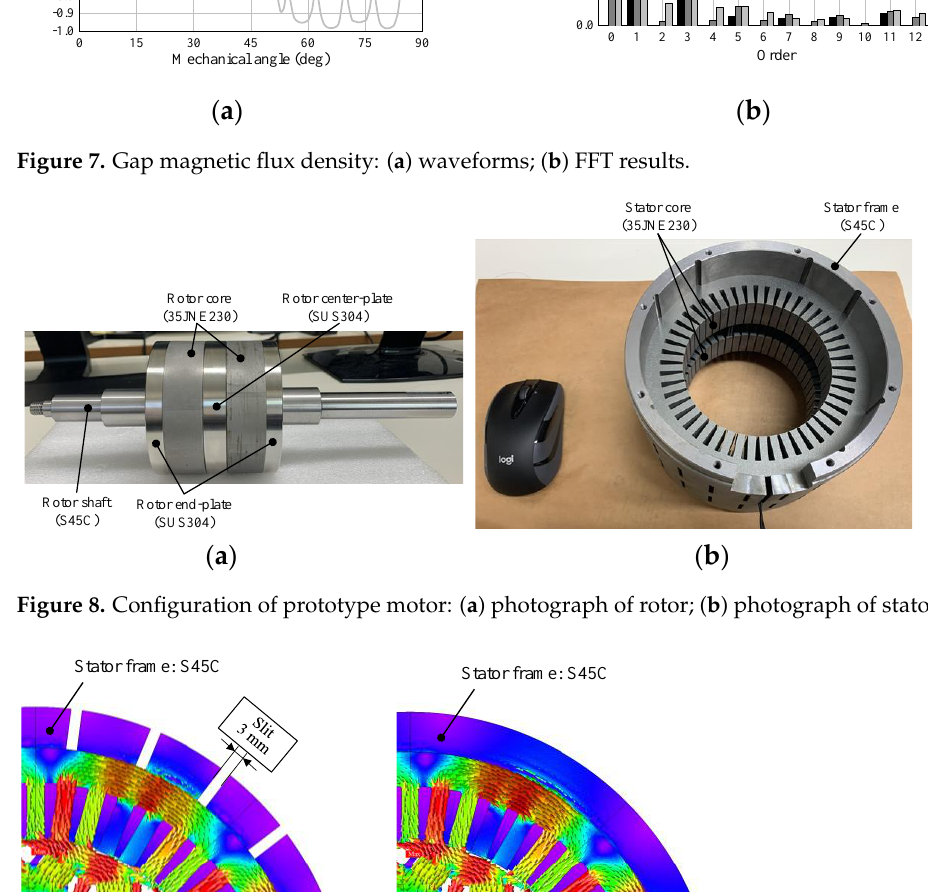
Figure 7. Gap magnetic flux density: ( a ) waveforms; ( b ) FFT results.